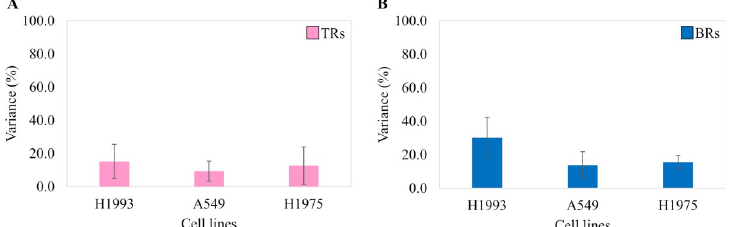
Fig 3. Variance analysis showing qualitative variability in TRs and BRs of three H1993, A549, and H1975 cell line exosomes.